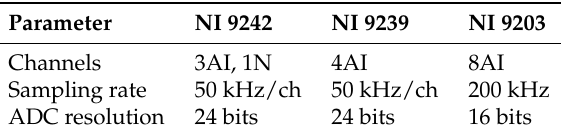
Table 2. Parameters of IO Modules.